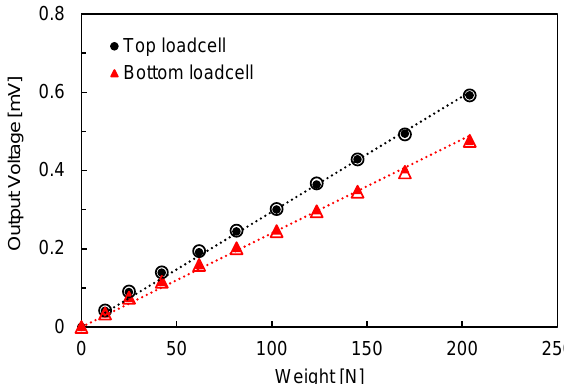
Figure 2. Calibration of load cells. Solid and hollow markers denote the loading and unloading steps, respectively.